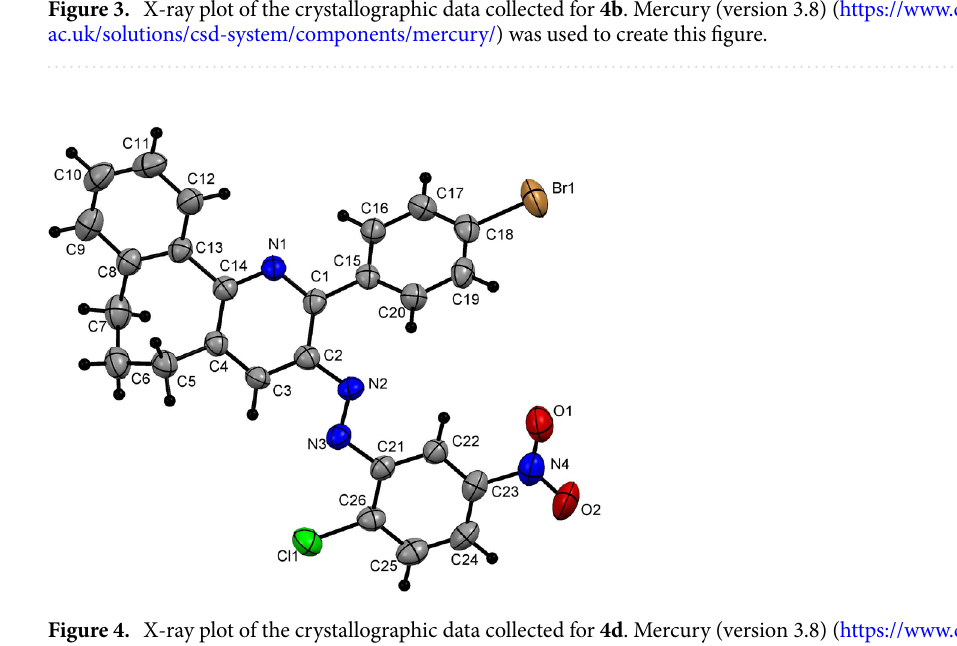
Figure 4. X-ray plot of the crystallographic data collected for 4d . Mercury (version 3.8) (https ://www.ccdc.cam. ac.uk/solut ions/csd-syste m/compo nents /mercu ry/) was used to create this